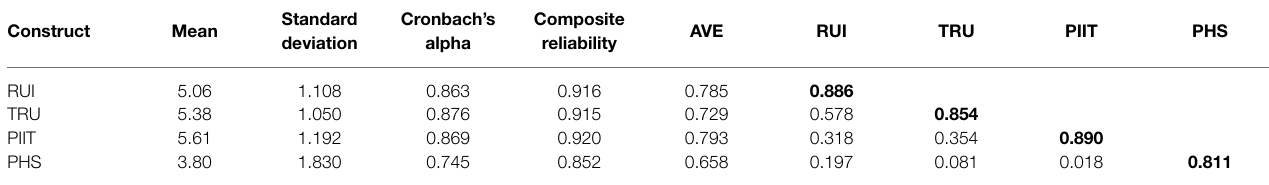
TABLE 3 | Correlations and discriminant validity. Construct